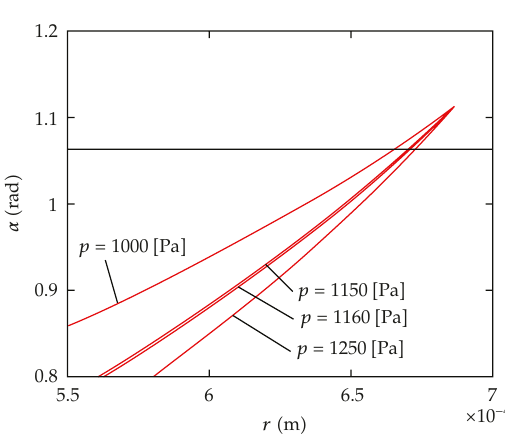
Figure 5: α versus r for p (cid:2) 1000 , 11500 , 1160 , 1250 (cid:5) Pa (cid:7) .